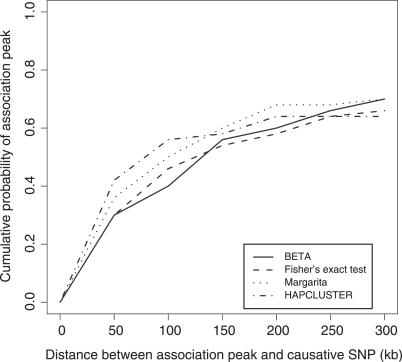
Cumulative Distribution of Distances between the Association Peak and the Causal SNPAnalysis of 50 datasets simulated under the default scenario, namely variable recombination rate, additive disease model, 1,000 cases and controls, SNP density of 1 kb, MAF of causal allele 5%, and 1.6 GRR(Aa).